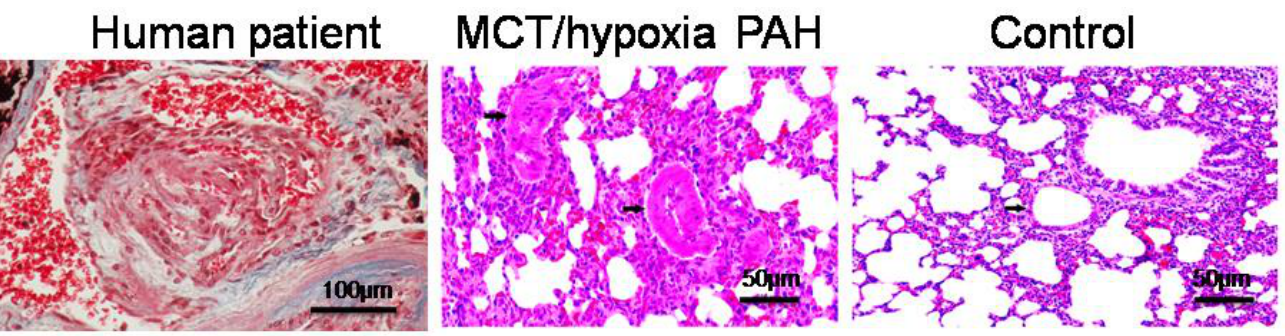
Figure 1. Histological section of the pulmonary artery. ( Left ) Human patient. The section was stained using the Masson stain method. Scale bar, 100 µm. ( Middle ) Rat PAH model and ( Right ) control. The sections were stained with hematoxylin and eosin. Scale bar, 50 µm.